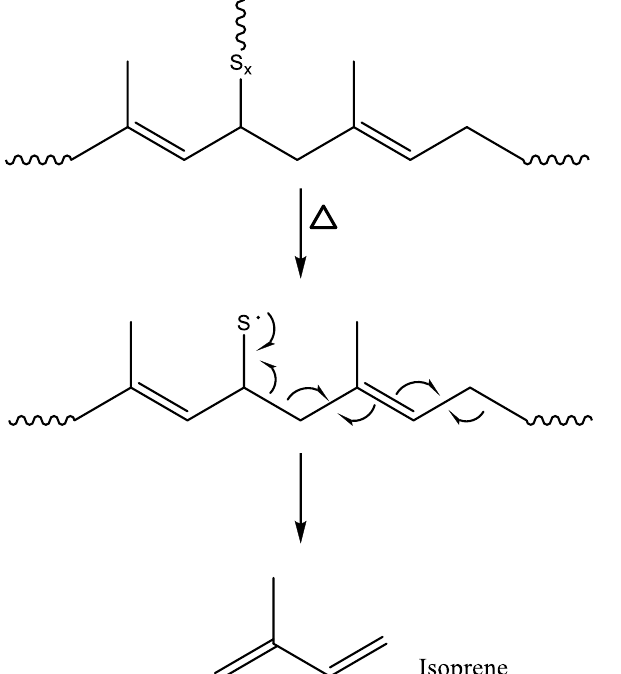
Scheme 2. Pyrolysis mechanism for the formation of isoprene from NR by dissociation of